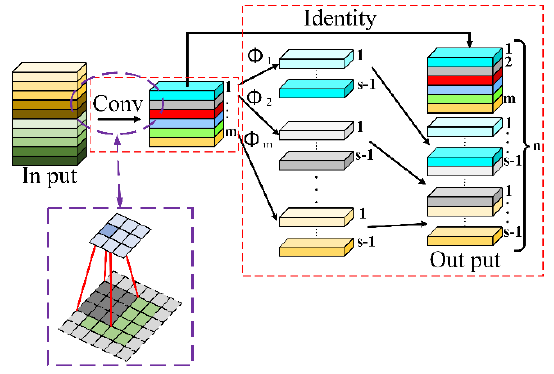
Figure 2. The Ghost Convolution process.